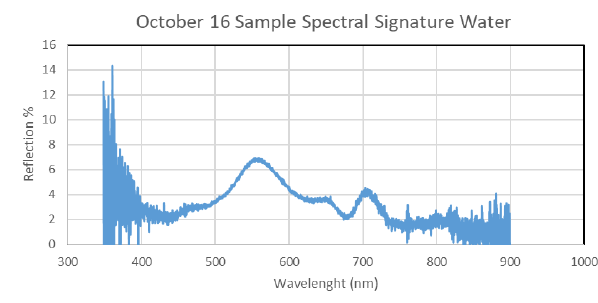
Figure 5. Sample Field Spectra for Oct 16, 2019 For water quality in situ measurements, a continuously data logging turbidity-chl-a sensor was deployed and towed along the boat track l (Figure 6). The sensor logged data every second for the whole duration of the field survey. Chlorophyll-a values obtained ranged from 3-20 µg/l. As seen in (Figure 6) the values of the chl-a differ throughout the lake. Areas in red (east part of the central bay) have higher values of chl-a compared to the green and yellow aras (rest of the area)